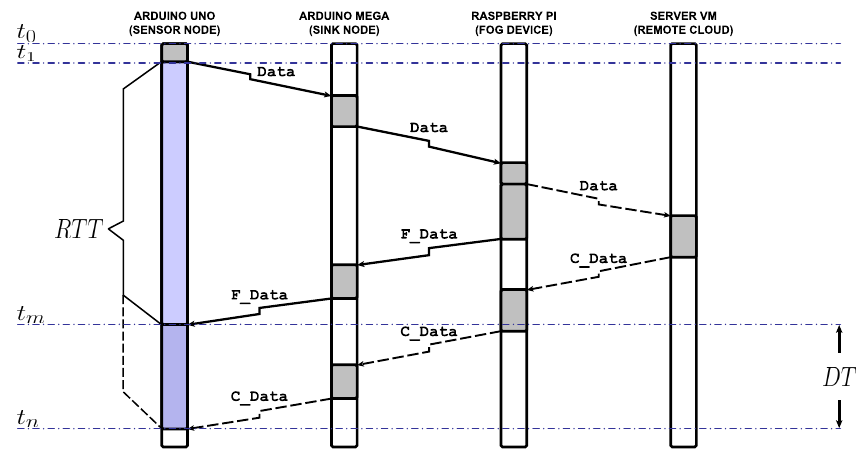
Figure 5. Calculation of the RTT , for both cloud and fog computing scenarios. The gray boxes symbolize the processing times along the route, whereas the arrows the transmissions that